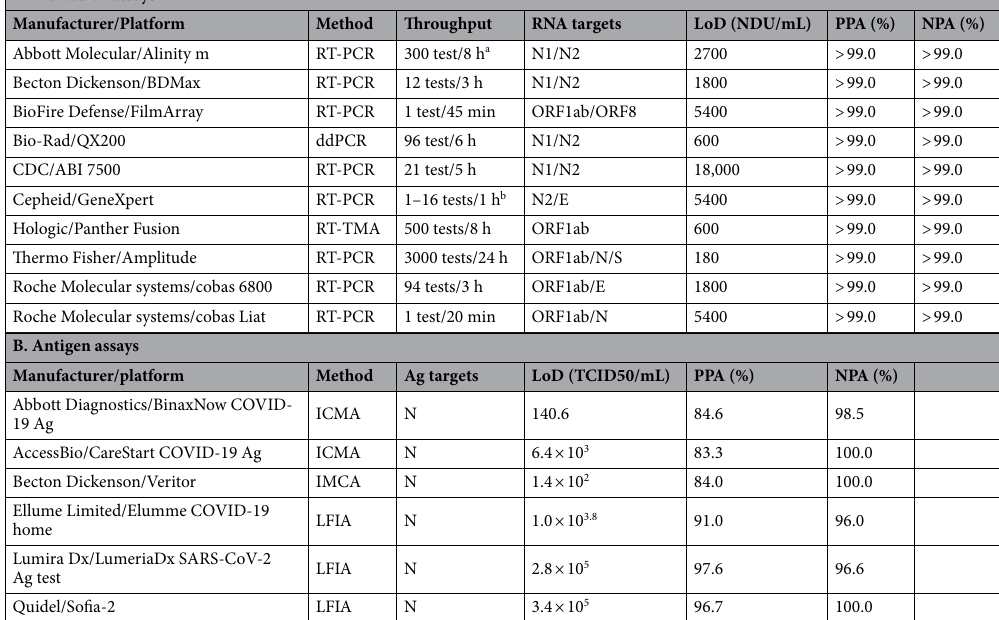
Table 1. Comparison of common emergency use authorized diagnostic methods for evaluating COVID-19 tests. ABI applied biosciences, Ag antigen, CDC Centers for Disease Control and Prevention, ddPCR digital droplet PCR, E envelope protein gene, IMCA immunochromographic membrane assay, LFIA lateral flow immunofluorescent assay, LoD limit of detection, N nucleoprotein gene, NDU nucleic acid test detectable